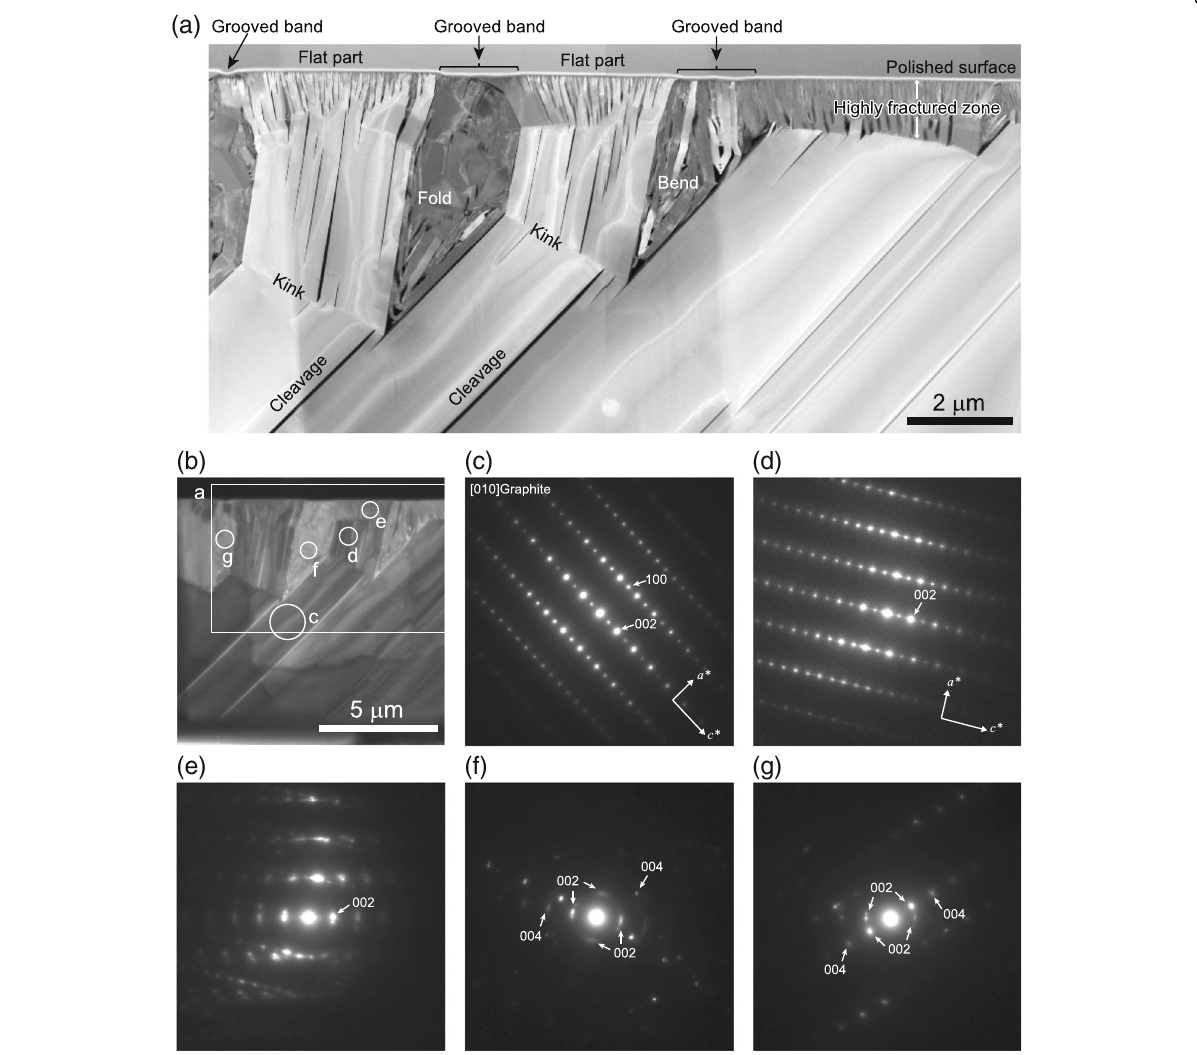
Fig. 6 a STEM image of the ultra-thin section of graphite cut by FIB. The top of the STEM image is the polished surface, which is covered by a coating of platinum and carbon. b Bright field (BF) TEM image of an ultra-thin section of graphite as cut by FIB. The white circles show the location of spots of the SAED patterns within the measured areas in ( c ) to ( g ). c The SAED pattern of the bottom part of the graphite sheet under the flat part shows clear 100 and 001 spots. d The SAED pattern of the area ~1.5 μ m below the flat part shows clear 100 and 001 spots. e The SAED pattern of the highly fractured zone in the flat part exhibits 100 and 001 spots. f The SAED pattern of the area under the grooved band showing weak 002 spots. g The SAED pattern of the area under a different grooved band indicate weak 002